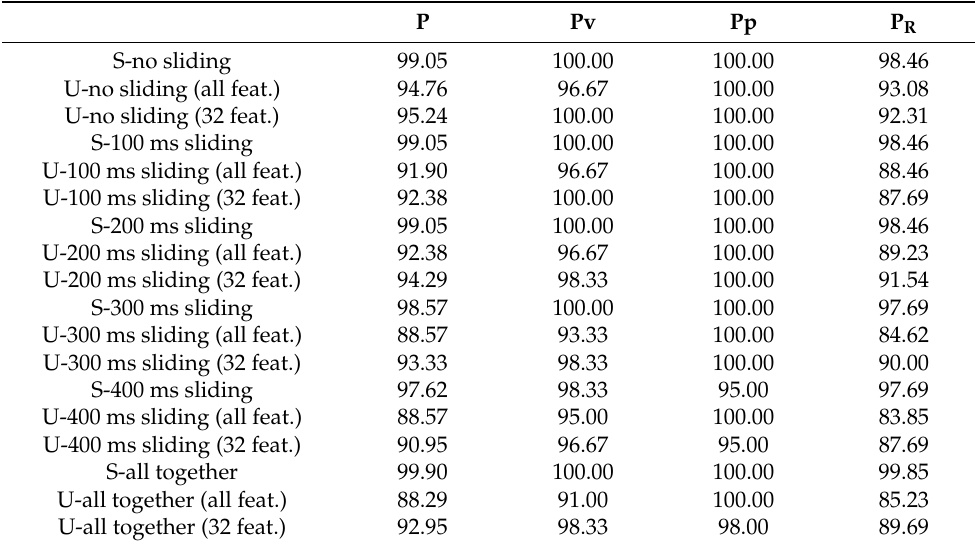
Table 9. Temporal sensitivity